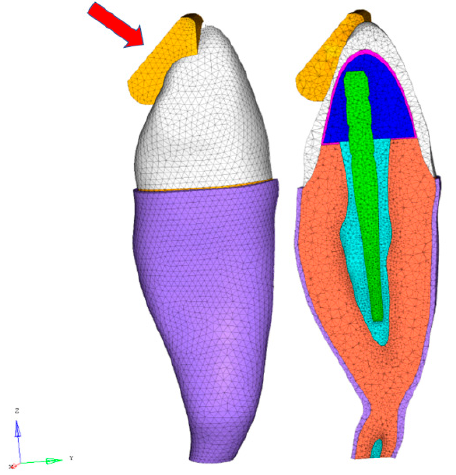
Figure 1. Finite element analysis (FEA) model according to the different components of the geometric models, mechanical properties and technical features.